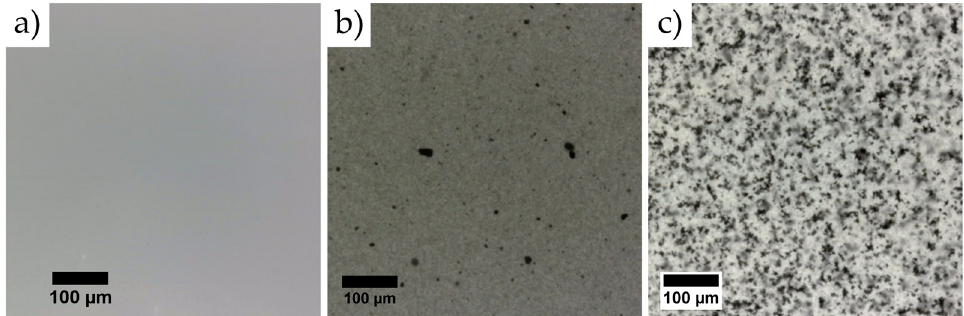
6 of 17 Figure 2. Preparation method for the PDMS/CNP membranes showing two mixing processes to